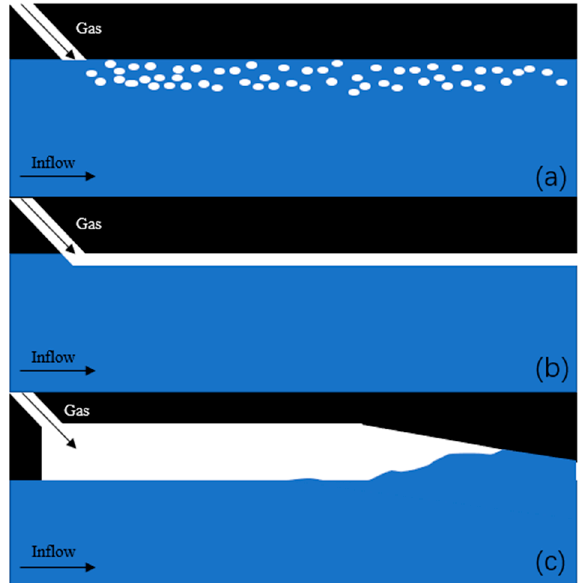
Figure 4. Three ALS styles, ( a ) bubble drag reduction, ( b ) gas layer drag reduction, and ( c ) gas cavity drag reduction.